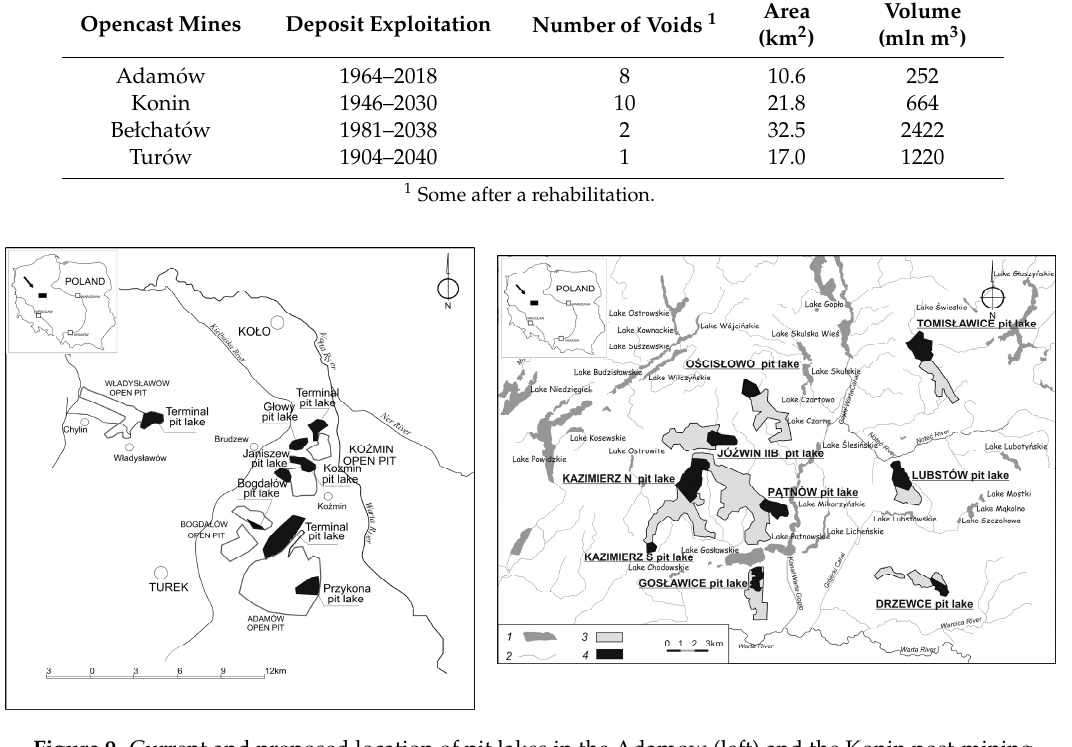
Figure 9. Current and proposed location of pit lakes in the Adamow (left) and the Konin post-mining area (right). Explanations: 1 —natural lake; 2 —river; 3 —post-mining area; 4 —pit lake [61].